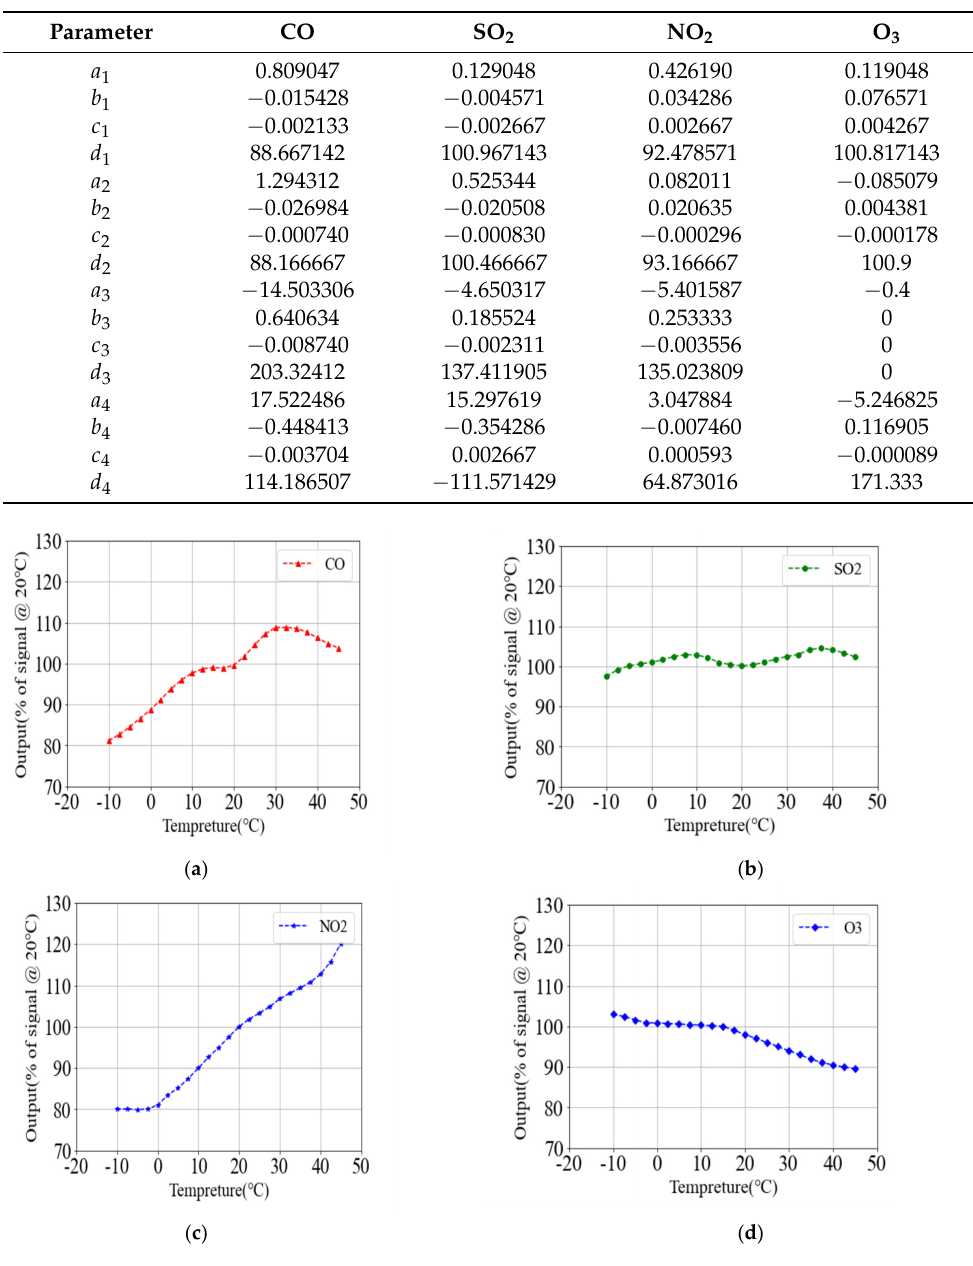
Figure 21. ( a ) CO gas temperature compensation curve; ( b ) SO 2 gas temperature compensation curve; ( c ) NO 2 gas temperature compensation curve; ( d ) O 3 gas temperature compensation curve. Table 5. Temperature compensation parameters.